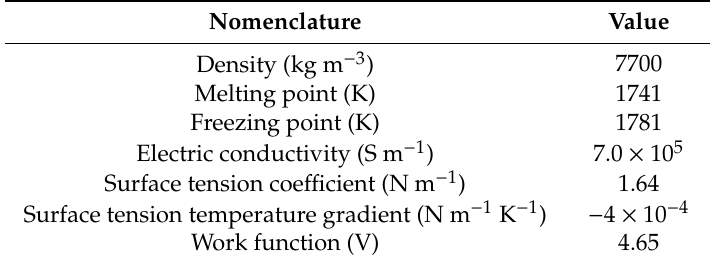
Table 3. Main physical properties of 409L stainless steel used in this